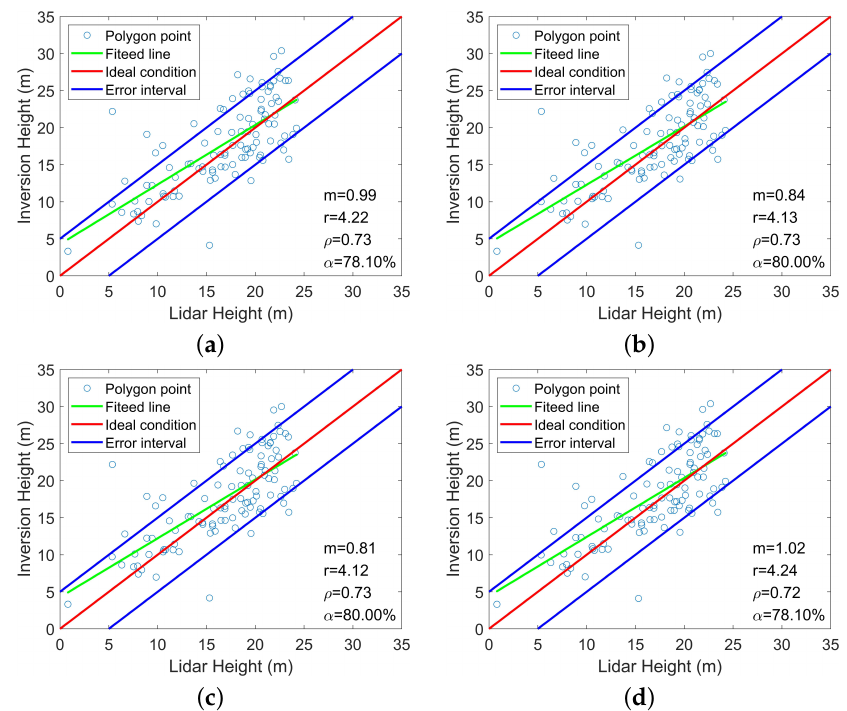
Figure 12. The correlation plots of L-band in different configurations. ( a ) TSIA + EBCR + LUT. ( b ) TSIA + IEBCR + ILUT. ( c ) TSIA + EBCR + ILUT. ( d ) TSIA + IEBCR +